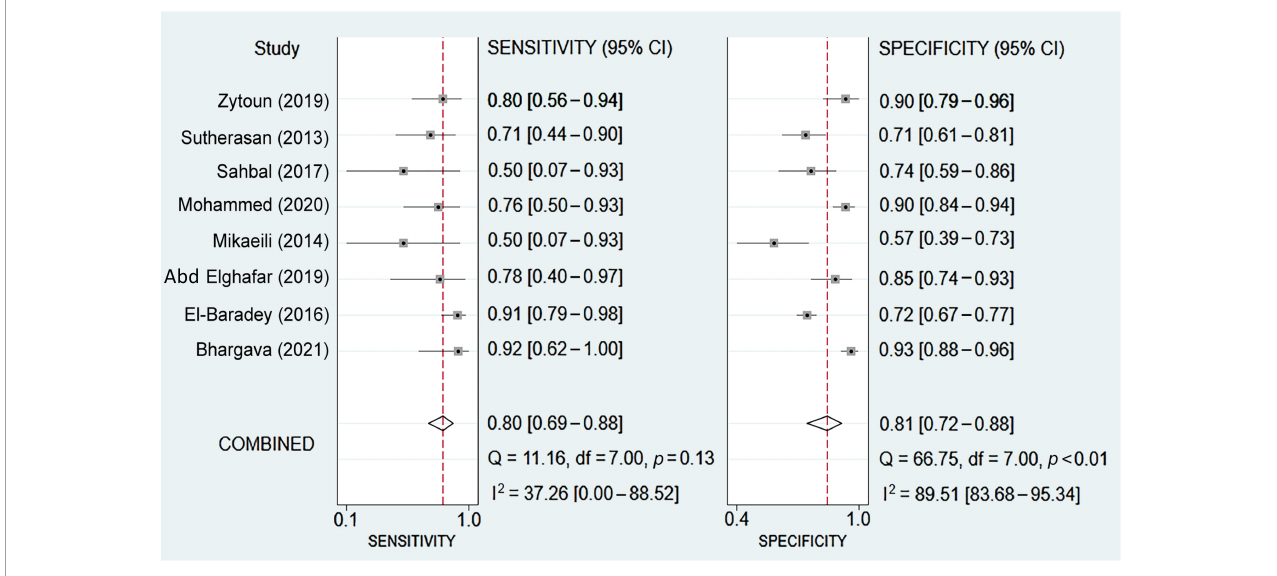
FIGURE4 Summary receiver operating characteristic (sROC) curve analysis of sensitivity and specificity of air column width difference (ACWD) for predicting post-extubation stridor (PES). Weighted sROC is shown as a solid line. Open circles denote estimates of sensitivity and (1–specificity) of individual studies. Diamonds represent pooled point estimates of outcomes. AUC, area under the curve; SENS, sensitivity; SPEC, specificity.